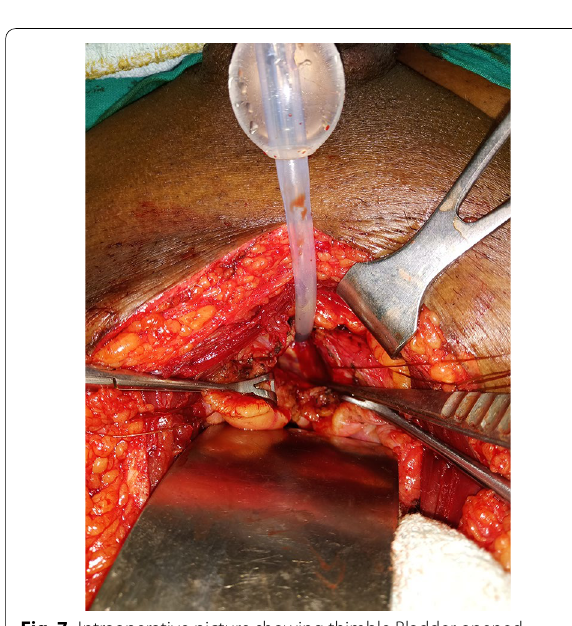
Fig. 7 Intraoperative picture showing thimble Bladder opened